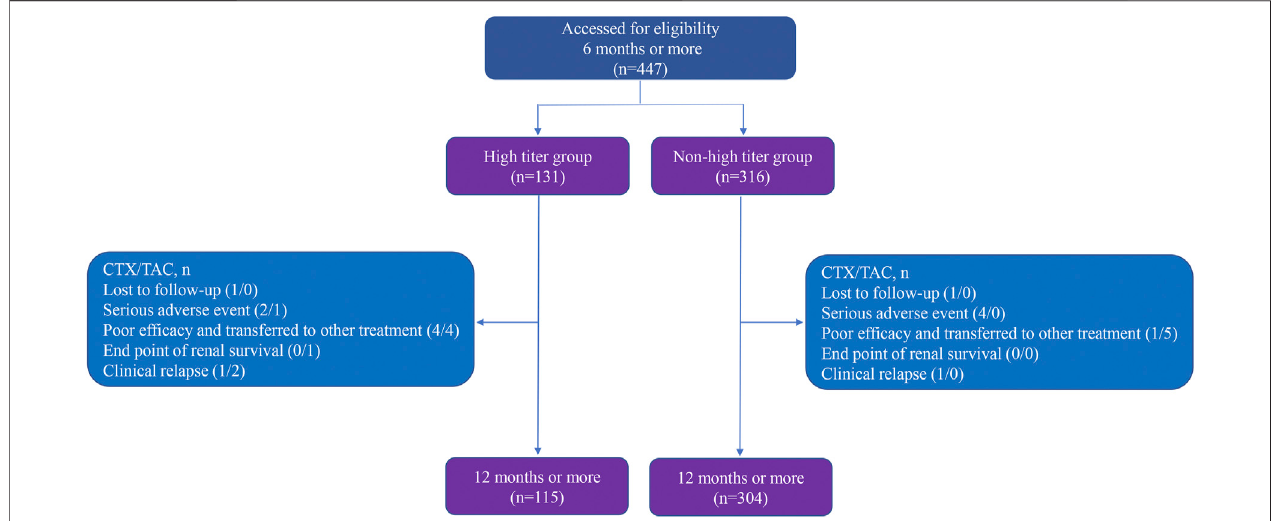
FIGURE 1 | Flow diagram of follow-up for enrollment of